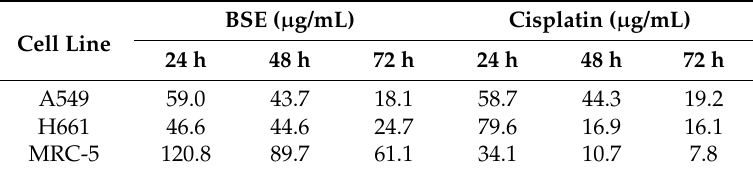
Table 1. Cytotoxicities (expressed by IC 50 value) of BSE and cisplatin on different lung cells. BSE ( μ g/mL) Cell Line